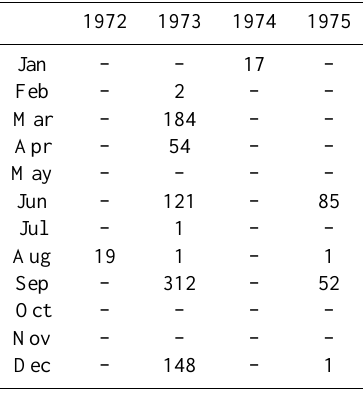
TEC values are used together with tomographic recon- struction algorithms to decompose the TEC into the dif- ferent values of the N e in the vertical for a relevant sce- nario ( Sutton and Na, 1996; Yizengaw et al., 2007). To achieve this, a priori information about the ionosphere is added to the method, typically from a range of back- ground ionospheres (for example, from a background model) representing many possible peak